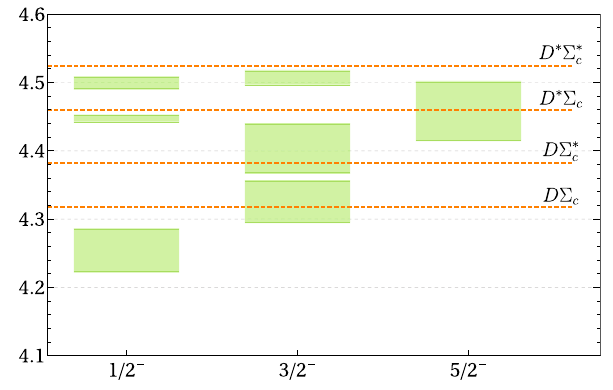
Fig. 6 Mass spectrum of the S -wave D (cid:2) ∗ c - D ∗ (cid:2) c - D ∗ (cid:2) ∗ c coupled- channel dynamics with ( I , J ) = ( 1 / 2 , 3 / 2 ) , S -wave D (cid:2) c - D ∗ (cid:2) c - D ∗ (cid:2) ∗ c system with ( I , J ) = ( 1 / 2 , 1 / 2 ) and S -wave D ∗ (cid:2) ∗ c channel with ( I , J ) = ( 1 / 2 , 5 / 2 ) , respectively. The cutoff (cid:4) is varied from 0 . 6GeV to 0 . 8GeV. For the resonances, only the real parts of their pole positions are